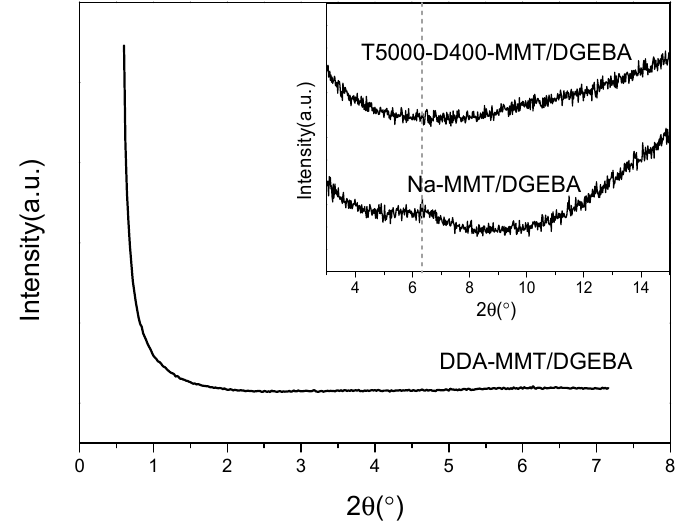
Figure 5. SAXS/XRD patterns of epoxy matrix nanocomposites reinforced by Na-MMT, T5000-D400-MMT and DDA-MMT at 3 wt % clay loading.